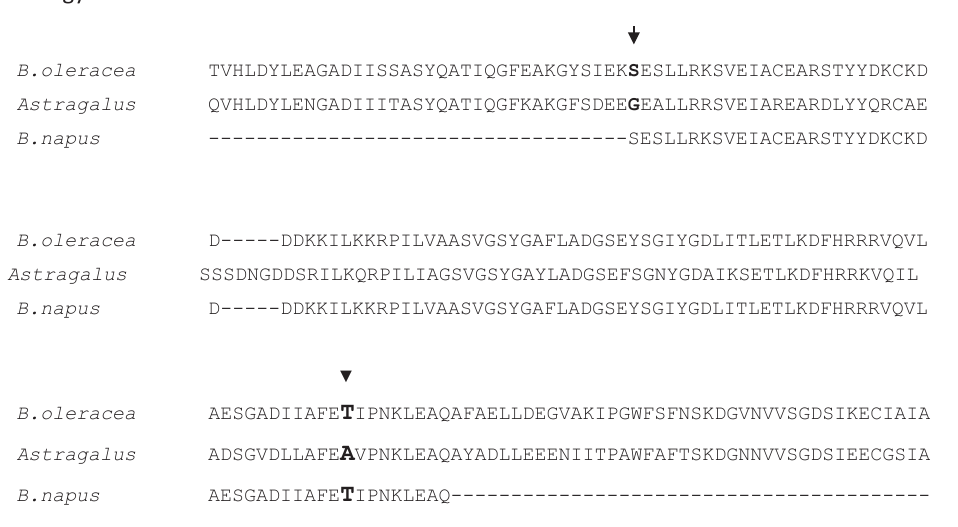
Fig. 2. Partial protein sequence alignment of selenomethyltransferase (SMT) of Brassica oleracea (GenBank: AY817737.1). Astragalus bisulcatus (AJ131433.1) and putative SMT sequence of Brassica napus . The